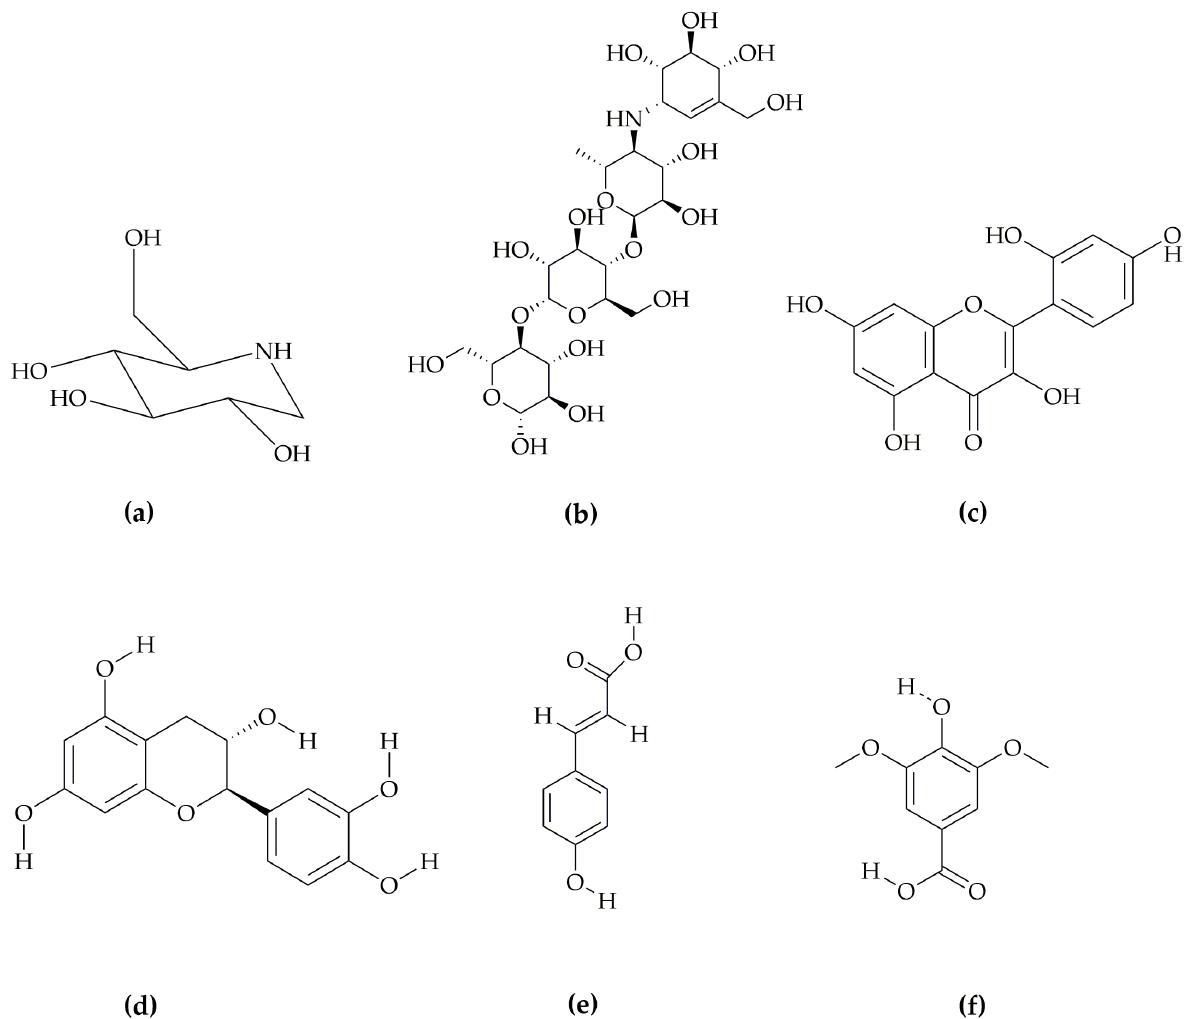
Figure 1. Chemical structures of the compounds to be docked with human α -glucosidase protein 5NN5: ( a ) 1-DNJ, ( b ) standard, ( c ) FTP1, ( d ) FTP2, ( e ) FTP3, and ( f ) FTP4; 1-DNJis1-deoxynojirimycin, standard is acarbose, FTP1 is morin, FTP2 is catechin, FTP3 is p -coumaric acid, and FTP4 is syringic acid.